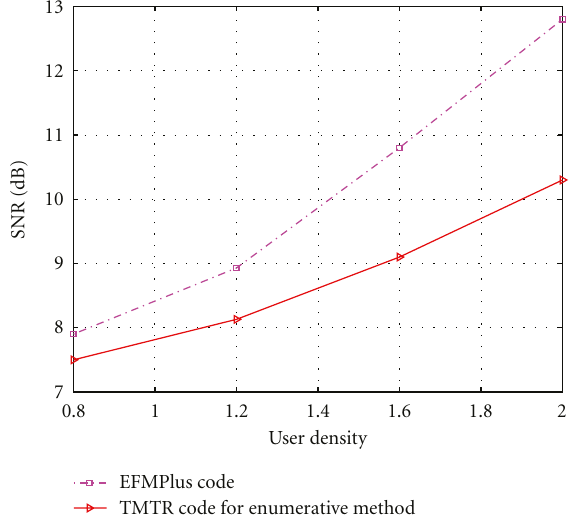
Figure 9: The SNR in dB required to achieve a 10 − 5 BER versus user